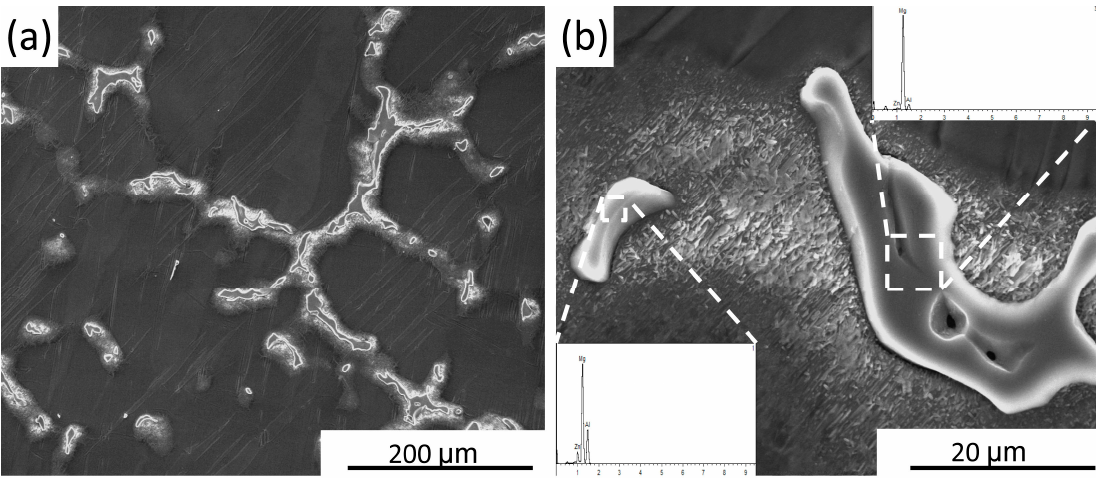
Figure 1. Scanning electron microscopy (SEM) images of the as-cast AZ61 specimen at ( a ) low magnification and ( b ) high magnification